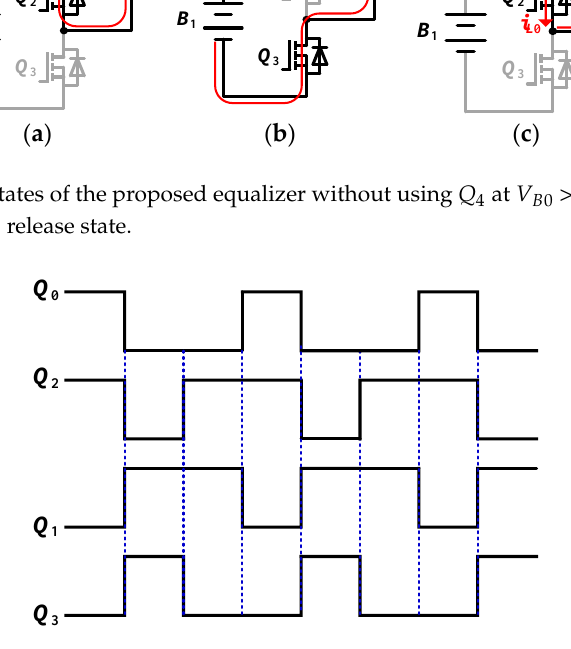
Figure 9. Switching sequences of the proposed equalizer without using Q 4 at V B 0 > V B 1 .